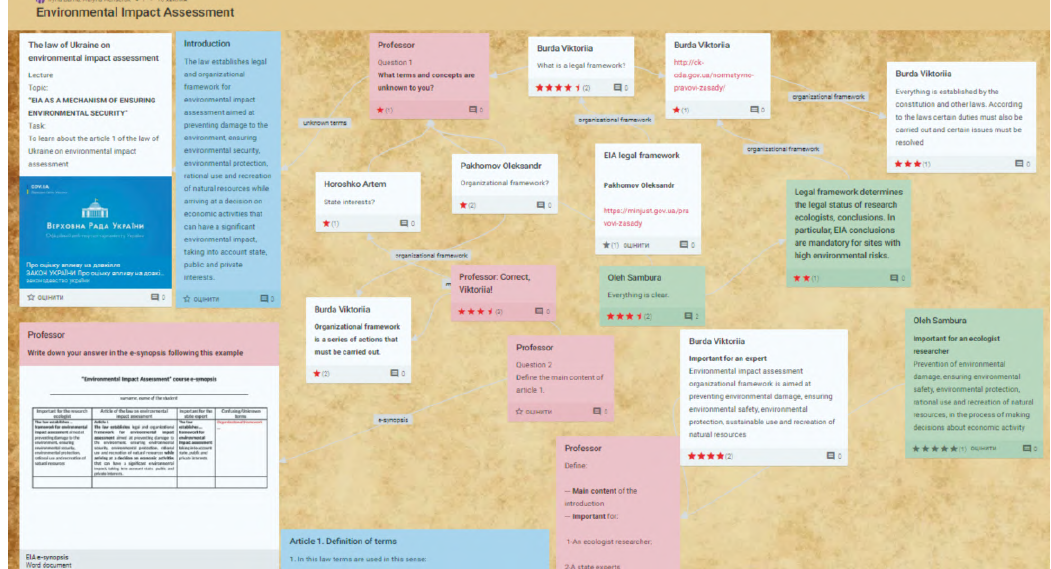
Figure 46: Presentation of paper